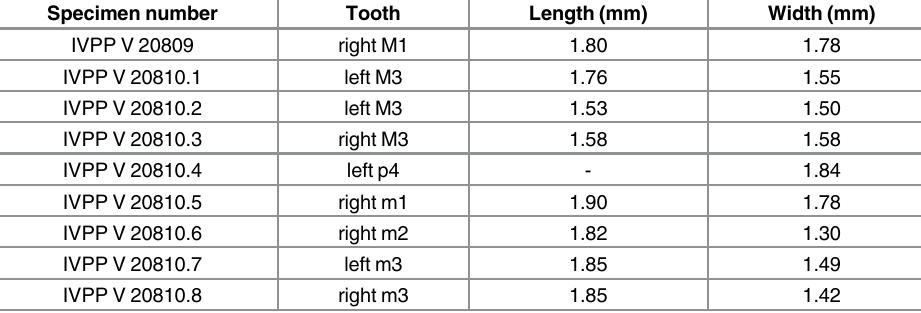
Table 2. Measurements for Irtyshogaulus major gen. et sp.